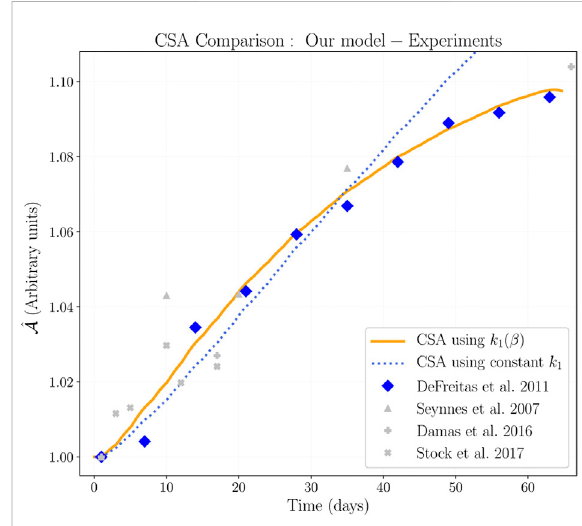
FIGURE 8 Normalized CSA adaptation due to training. Experimental results compared toour mechanobiological model. The activation function shown in Figure 6 was used to feedback equation system Eqs 1a, 1b, 1c, 1d, 1e. The modi fi ed protein synthesis rate k 1 ( β ) was de fi ned in Eq. 15, and replaces the constant value of the protein synthesis rate in function f ( x 3 , x 4 ) de fi ned through Eq. 2. We simulated the training protocol of DeFreitas et al. (2011), and fi tted parameters d d 1 and 2 to minimize the